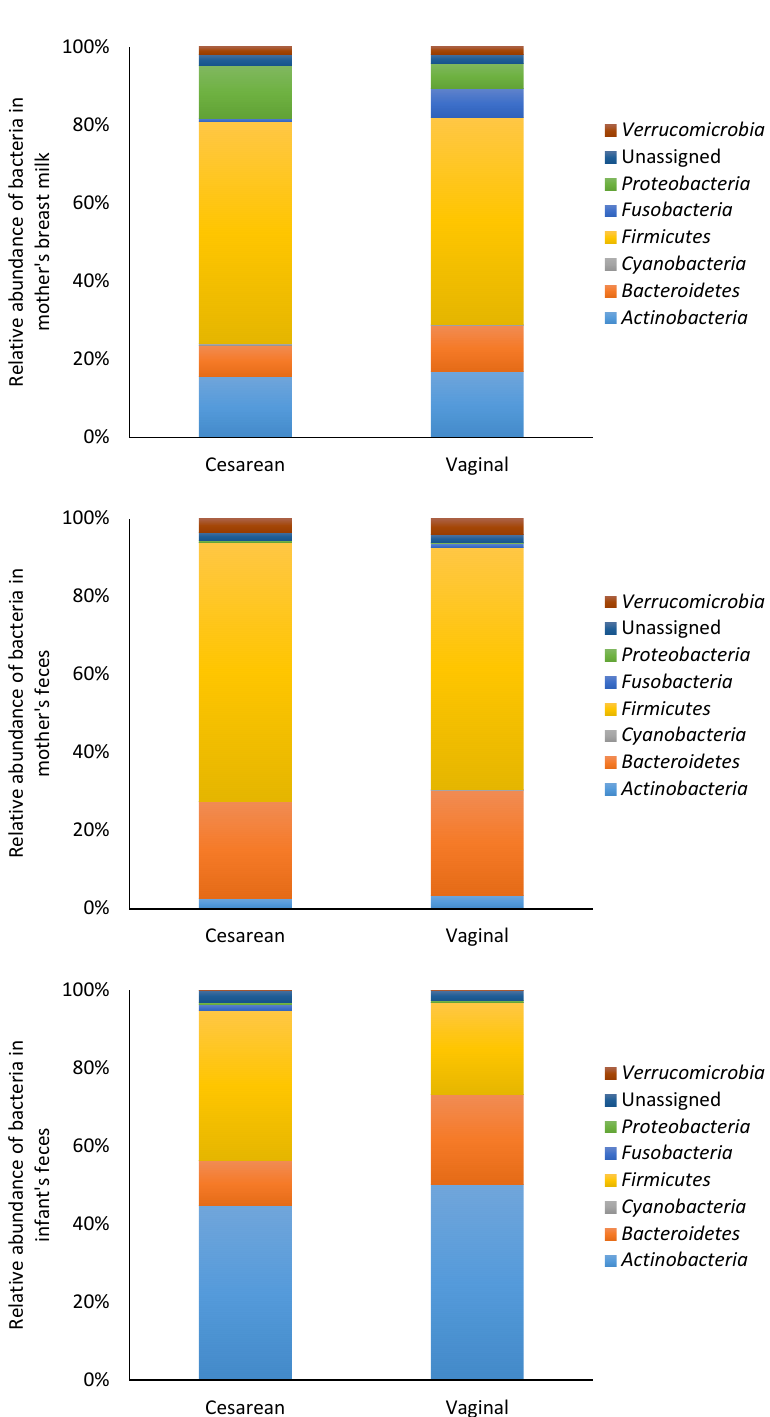
Figure 4. Relative abundance of bacteria at the phylum level in mother and infant. The data were categorized according to the mode of delivery.